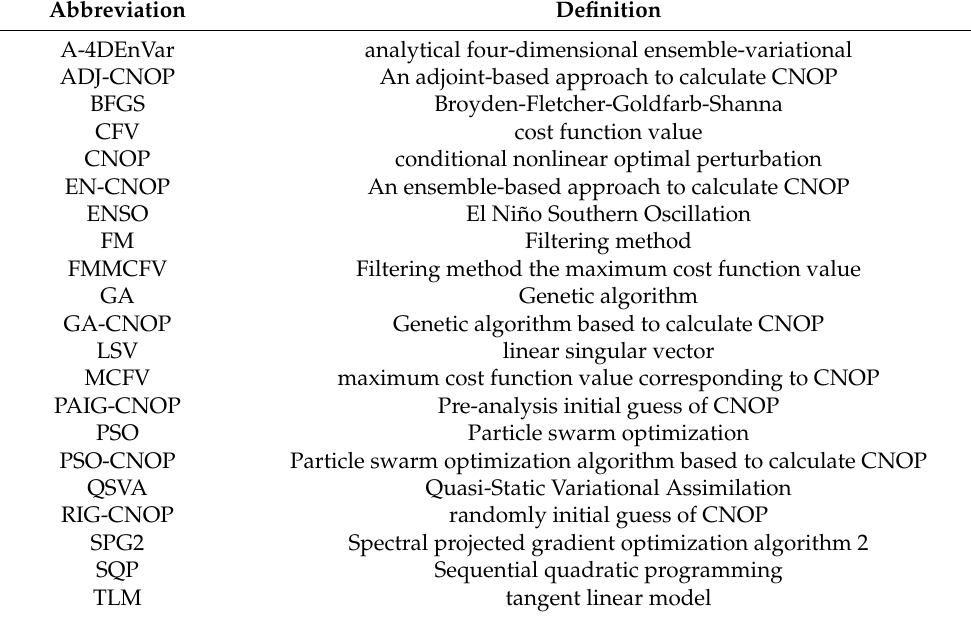
Table A1. Abbreviations and definitions used in this paper.